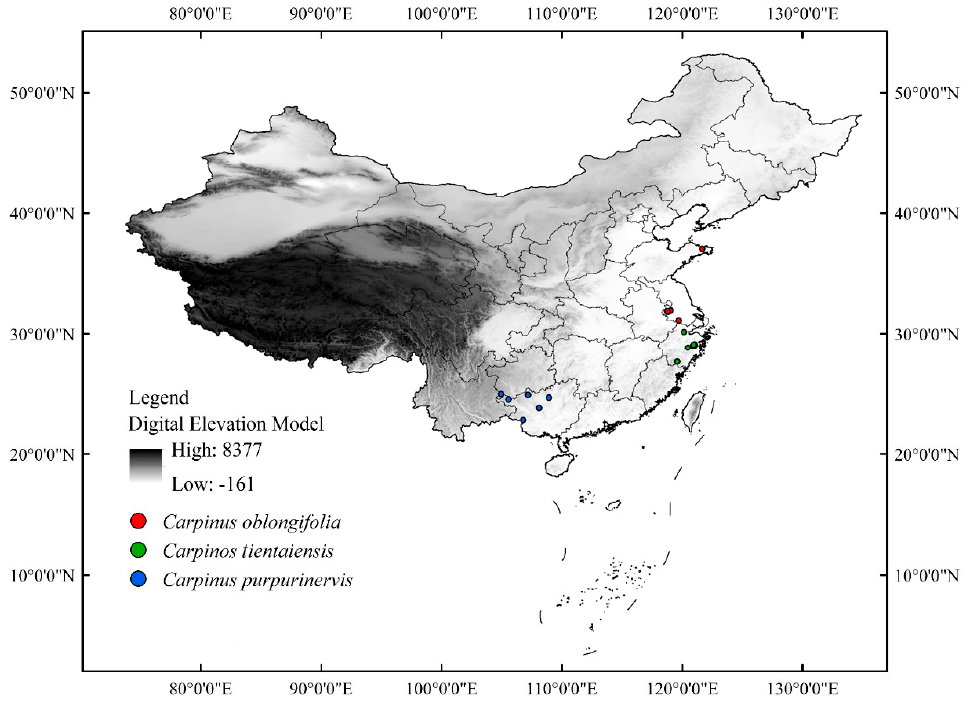
Figure 1. Distribution of observed occurrences of the three Carpinus species. Table 1. Climate variables and a human footprint index that used for developing the MaxEnt